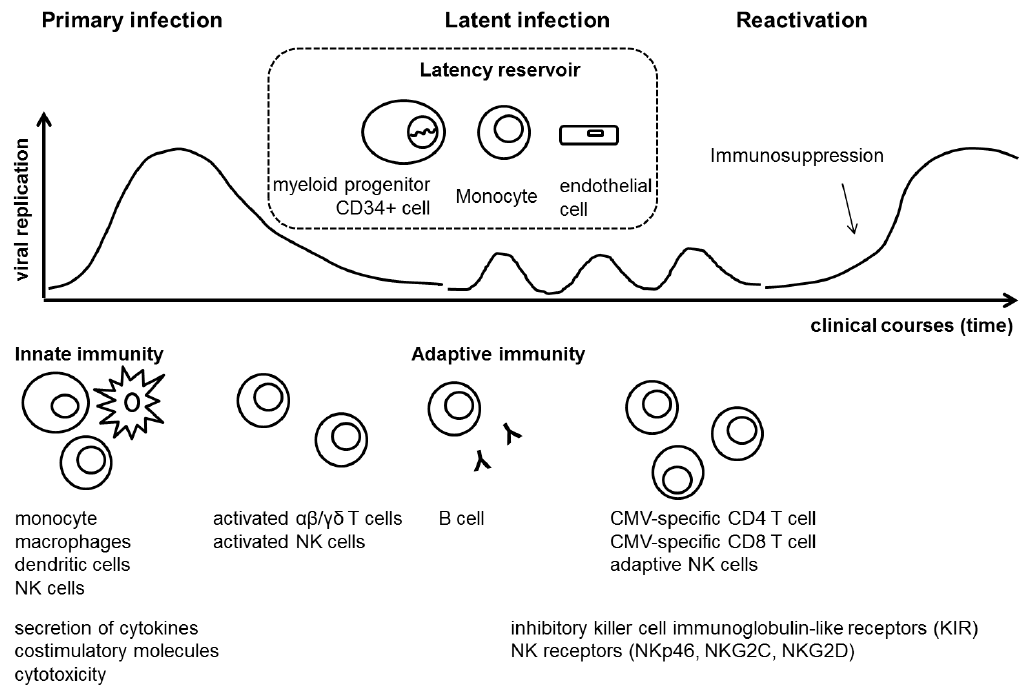
Figure 1. Overview of host immune response after cytomegalovirus infection.